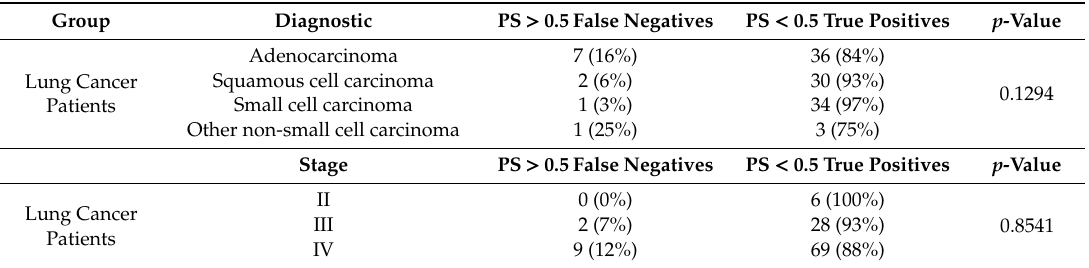
Table 7. Contingency table for clinical history information (probability score (PS) threshold = 0.5). Group Diagnostic PS > 0.5 False Negatives PS < 0.5 True Positives p -Value Adenocarcinoma 7 (16%) 36 (84%) 0.1294Squamous cell carcinoma 2 (6%) Lung Cancer 1 (3%) 34 (97%) Patients Other non-small cell carcinoma 1 (25%) 3 (75%) Stage PS > 0.5 False Negatives PS < 0.5 True Positives p -Value II 0 (0%) Lung Cancer Patients 69